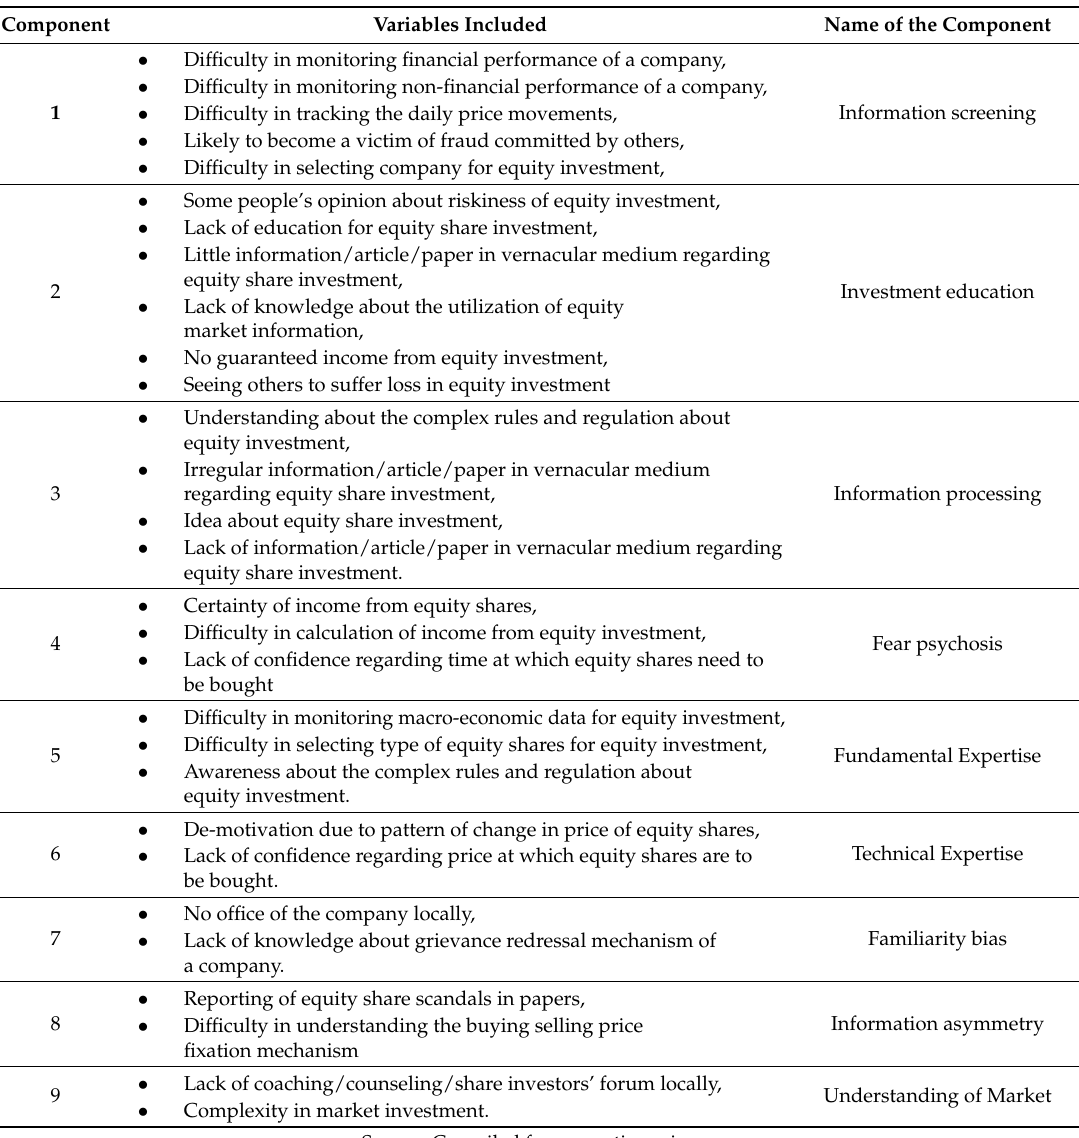
Table 10. Results of Factor